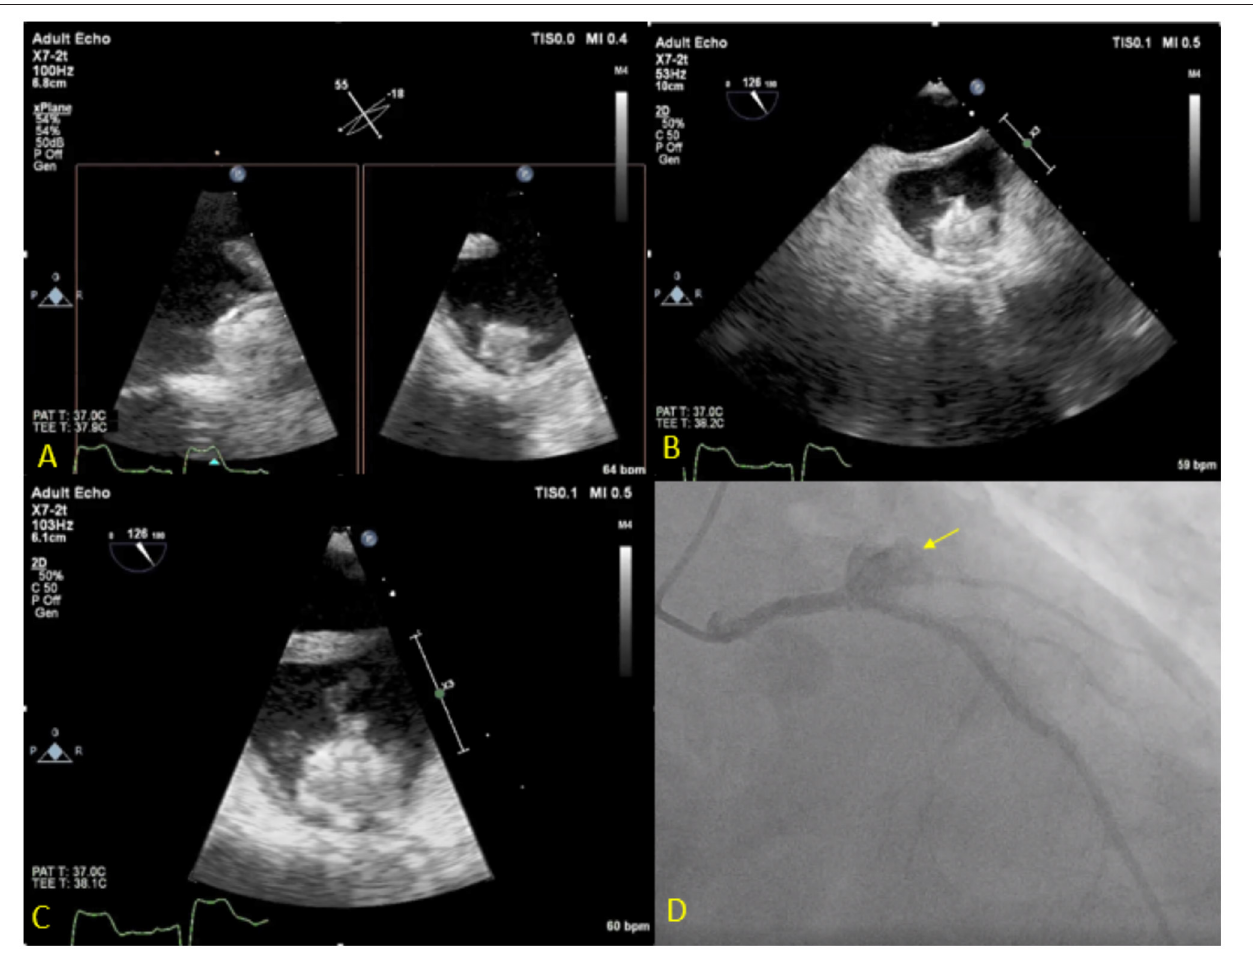
FIGURE 7 | Seventy three year-old male with history of CAD s/p multiple PCIs and Afib s/p Watchman implantation 3 weeks prior to presentation, presented with fever, chest pain and confusion. Blood cultures grew Serratiamarcensens. TEE (A–C) shows Watchman device in the left atrial appendage with large mobile vegetations. Course was complicated by distal embolization to the brain an intestine vasculature. Patient developed worsening chest pain and ST depressions, coronary angiogram (D) shows total occlusion of the proximal left circumflex artery secondary to mycotic aneurysm (Arrow). The patient was deemed too high risk for surgery and was treated